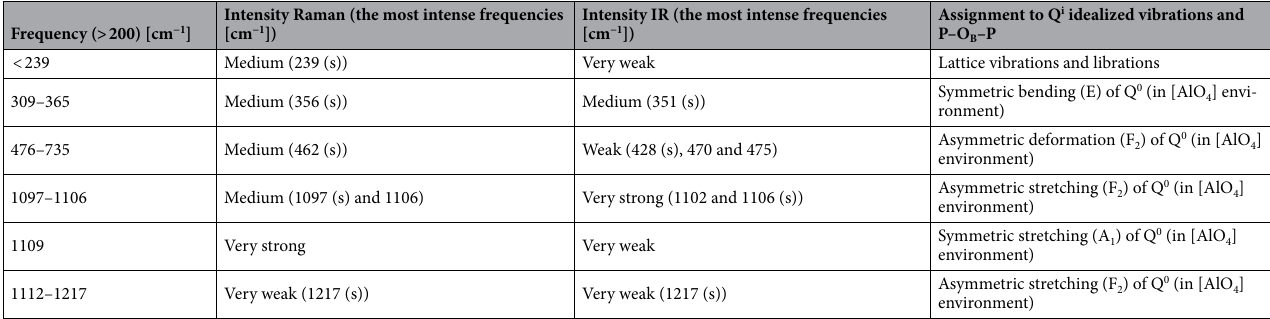
Table 6. The calculated Raman and IR active modes of α-cristobalite type AlPO 4 (more details in the supplementary materials Table S1.6). S—the strongest in range.